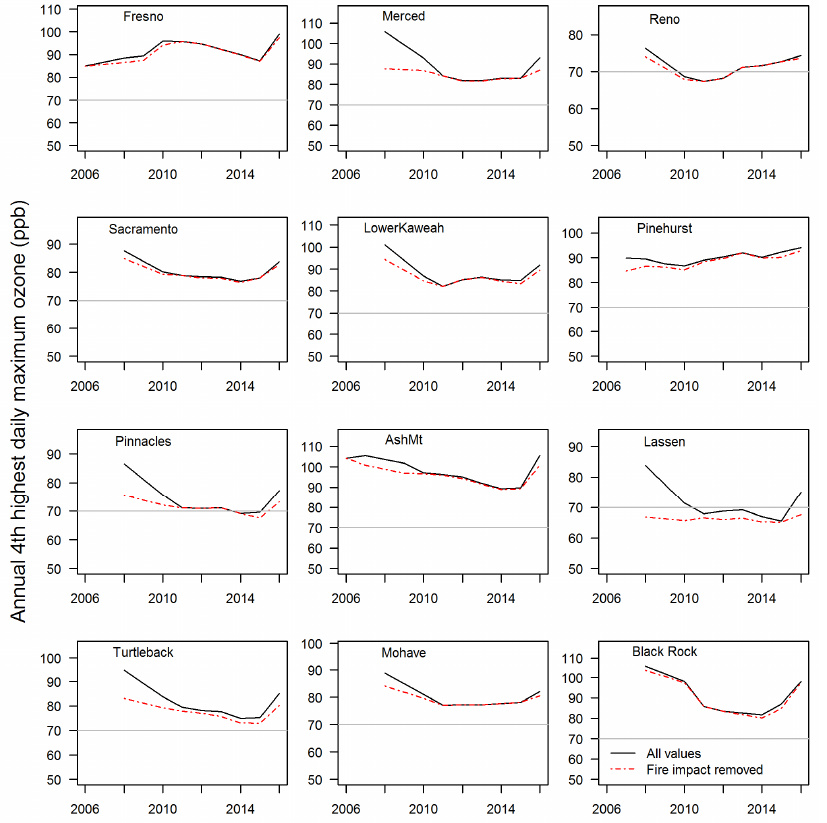
Figure 4. Annual 4th highest mean daily maximum 8hr value (MDA8) (averaged over three years) for 12 of the sites in our study, calculated using all values (black) and only values not impacted by fire (red).